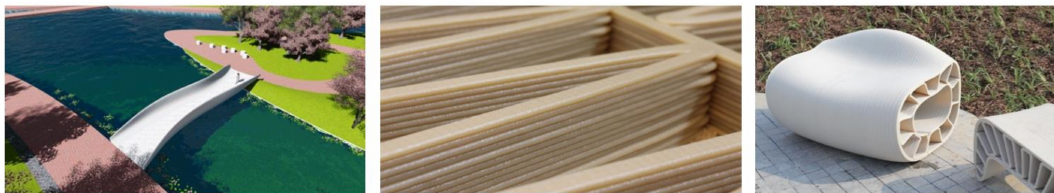
Figure 1. First 3D-printed bridge in China, Shanghai ( left ); 3D printing infill pattern ( middle ); 3D-printed cross section ( right )